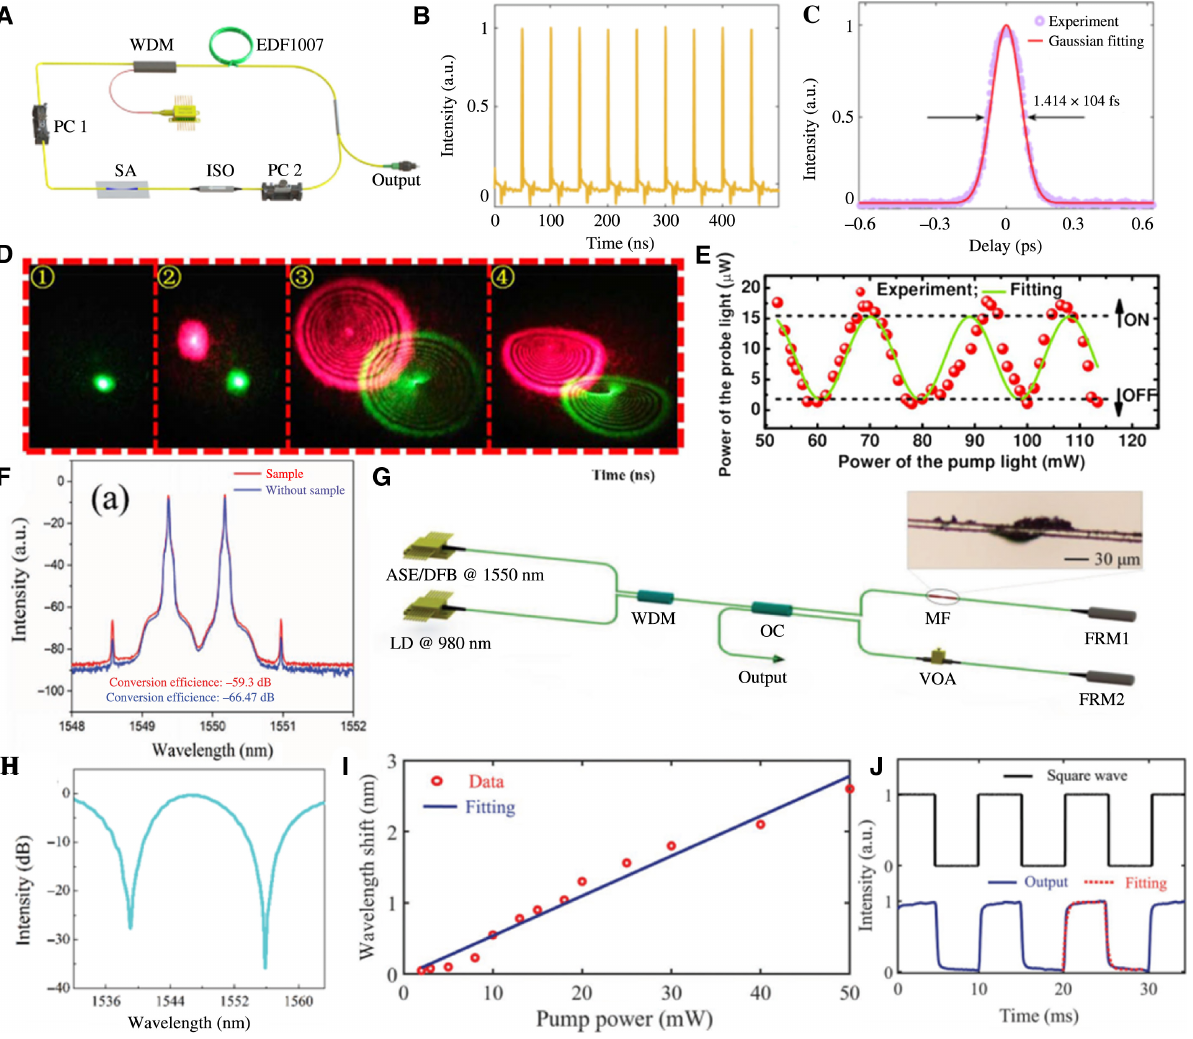
Figure 10: Modulators fabricated with MXenes. (A) Schematic of the stretched-pulse mode-locked fiber laser with the microfiber-based Ti C T saturable absorber. (B) Output pulse train 3 2 x of the stretched-pules fiber laser based on the Ti C T saturable absorber. (C) Autocorrelation of the output pulses and Gaussian fit, with a 3 2 x pulse duration of 104 fs. (D) Images for the process of diffraction ring changes: � The probe light with a low intensity below the threshold; � The other pump light with a stronger intensity was coupled with the probe light to interact with the sample; � the diffraction rings were stimulated quickly; � due to the non-axis-symmetrical thermal convection, the diffraction rings collapsed. (E) The probe light was controlled by the pump light to show “ON” and “OFF” modes in Ti C T -based all-optical switcher. (F) Optical spectra of MXene-decorated microfiber 3 2 x wavelength conversion, showing four-wave mixing effect. (G) Schematic of the Mxene-based all-optical modulator, inset: OM image of MXene-deposited microfiber. LD, laser diode; ASE, amplified spontaneous emission; DFB, distributed feedback; WDM, wavelength division multiplexer; OC, optical coupler; VOA, variable optical attenuator; MF, microfiber; FRM, Faraday rotation mirror. (H) Interferometric spectrum of Mxene-based all-optical phase modulator (I) Diagram of wavelength shift as a function of pump power. (J) Waveforms of 980 nm pump light (top) and single light output (bottom) and its fitting curve. (A–C) Reproduced with permission [85]. Copyright 2019, The Optical Society. (D–E) Reproduced with permission [165]. Copyright 2018, Wiley-VCH. (F) Reproduced with permission [166]. Copyright 2019, Wiley-VCH. (G–H) Reproduced with permission [167]. Copyright 2019, Wiley-VCH. (I–J) Reproduced with permission [168]. Copyright 2020,